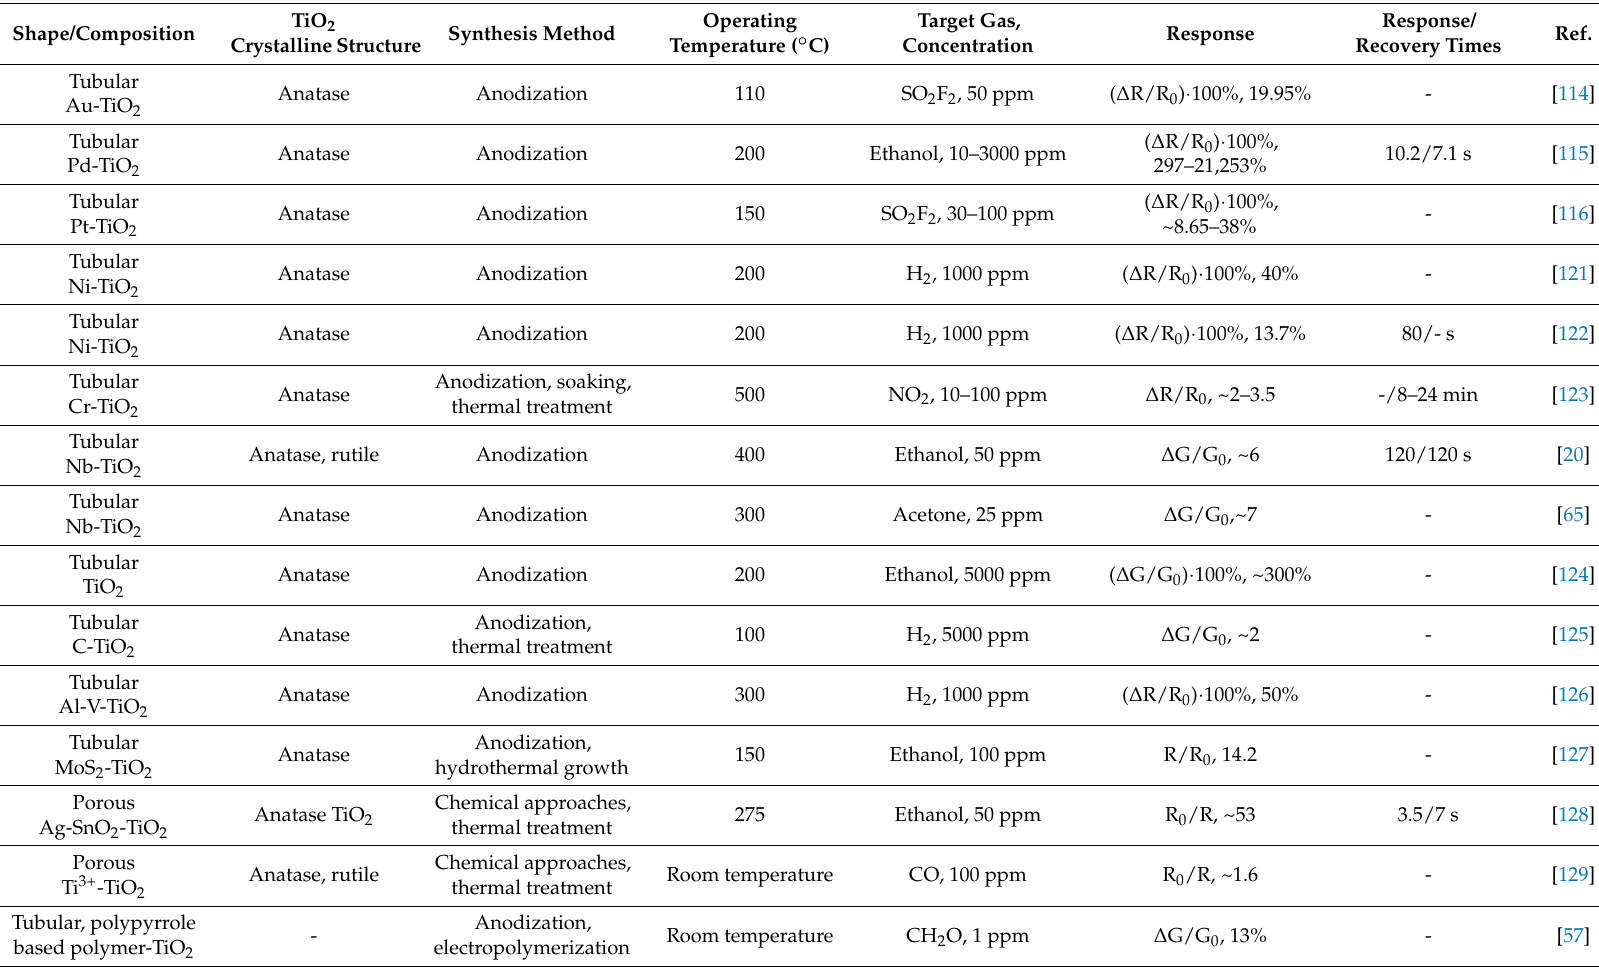
Table 2. Gas sensing performance of TiO 2 based porous and tubular structures at the optimal operating